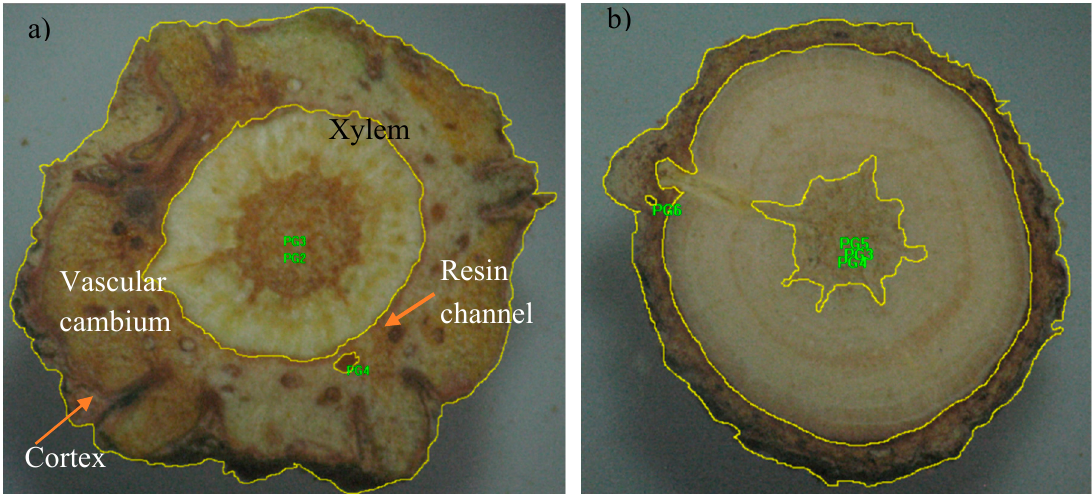
Figure 3. Anatomical sections of grafted organs of Pinus engelmannii Carr., observed at a total magnification of 40 × : ( a ) scion, ( b ) rootstock.